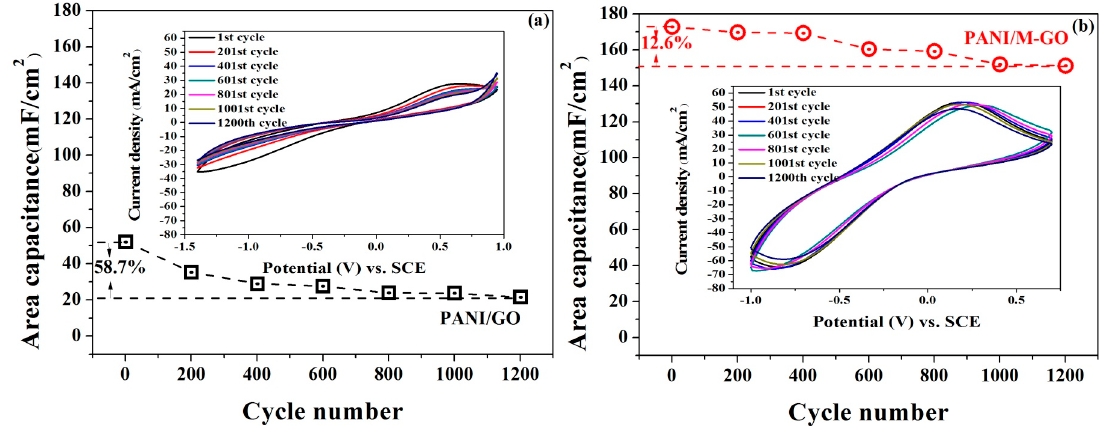
Figure 5. Cycle stability of ( a ) PANI/GO and ( b ) PANI/M-GO composite electrode during the multiple CVs process.